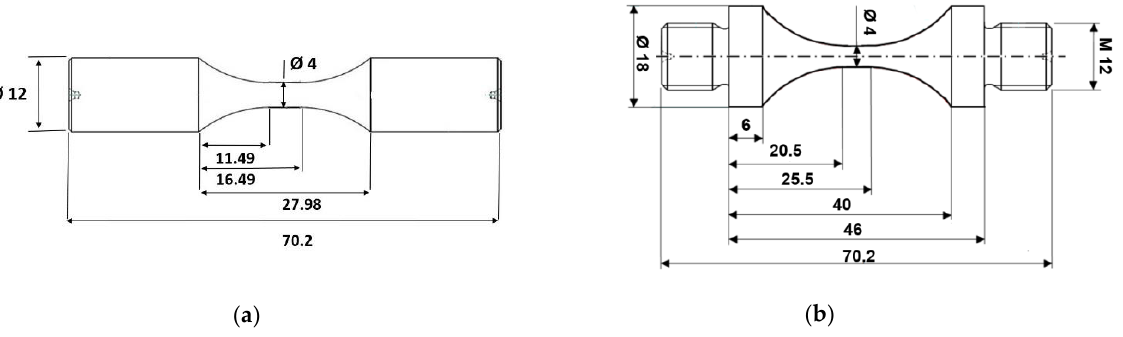
Figure 1. Specimen geometry used for the experiments (all dimensions in mm): ( a ) for HCF specimens; ( b ) for VHCF specimens.